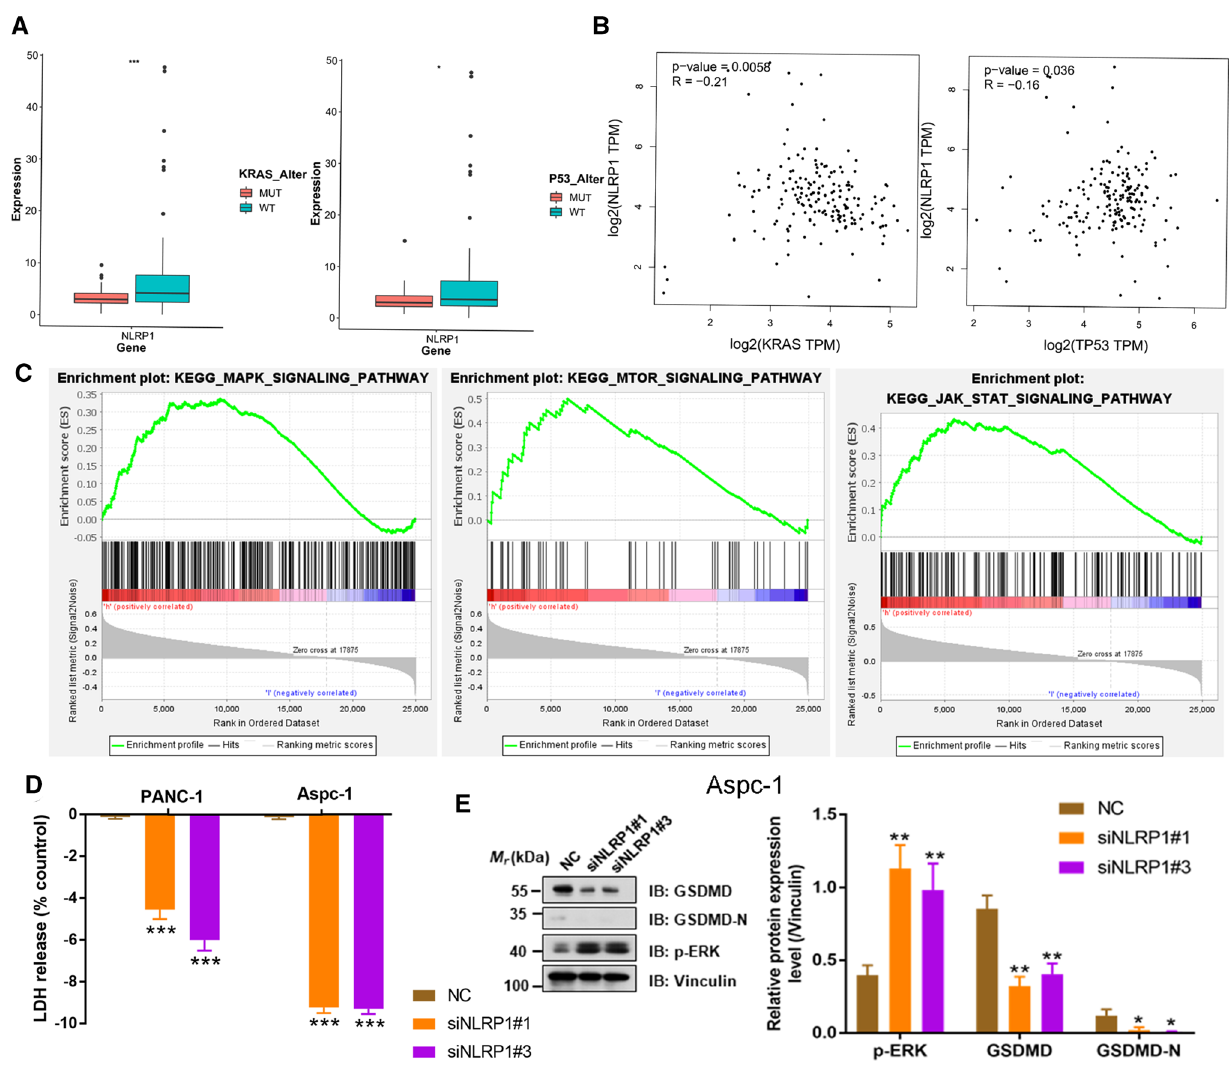
TCGA database. C GSEA analysis of DEGs in high NLRP1 expression group. D PANC-1 and Aspc-1 cells were tested for LDH release 24 h after siNLRP1 transfection. E Cleavage of GSDMD and p-ERK were monitored by immunoblot analysis 48 h after siNLRP1 transfection (*P < 0.05, ***P <